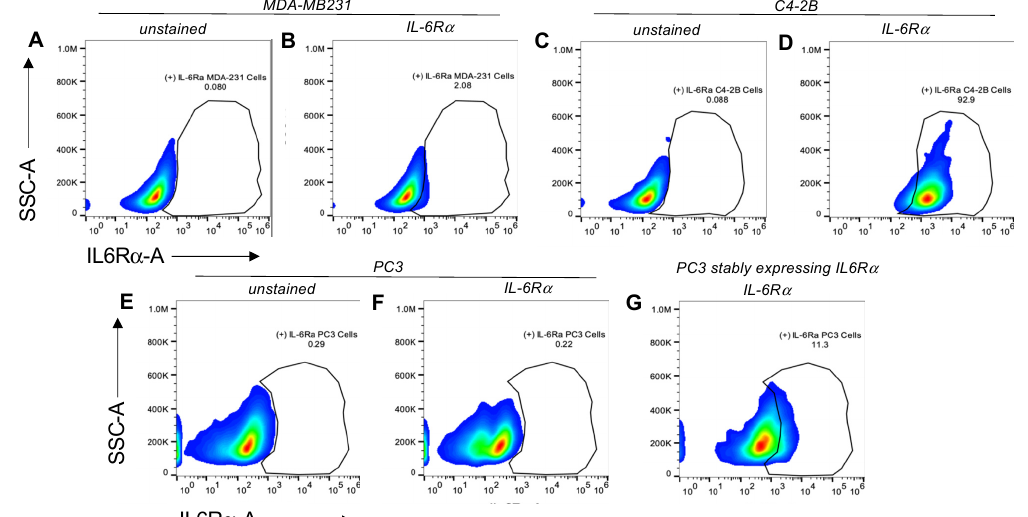
Figure 5. IL-6R α -expression profile on the surface of cells utilized in STAT-1/-3-activation assays. MDA-231 cells ( B ) serve as a model of cell lines with ‘lower levels’ of the receptor. ( A , C , E ) are unstained controls of tested cell lines. More than 90% of C4-2B cells ( D ) expressed measurable levels of IL6-R α . PC3 cells expressed negligible levels of IL-6R α ( F ), while ~11% of PC3 cells stably expressing an IL6R α construct (plasmid transfection and antibiotic selection) showed detectable levels of the receptor ( G ).